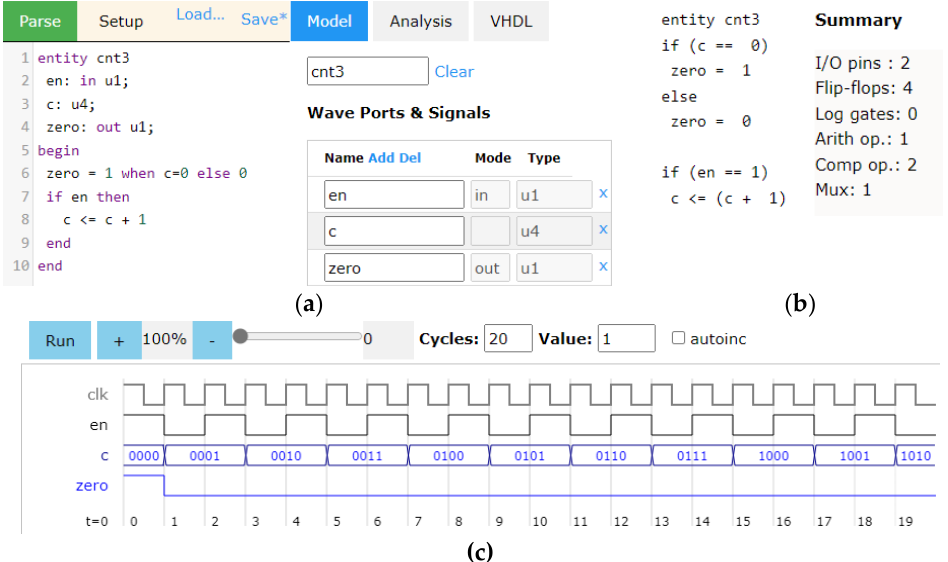
Figure 3. Counterexample in SHDL tool: ( a ) model description; ( b ) parser analysis and resource report; ( c ) simulation excerpt.